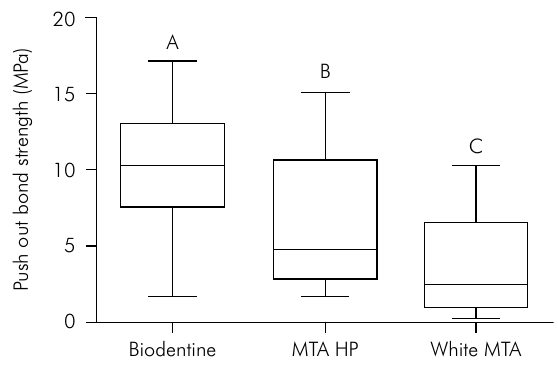
Different superscript letters indicate significant push-out differences among the materials (p < Figure 2. Box-plot with the median, the range and the minimum and maximum push-out values of the tested materials.